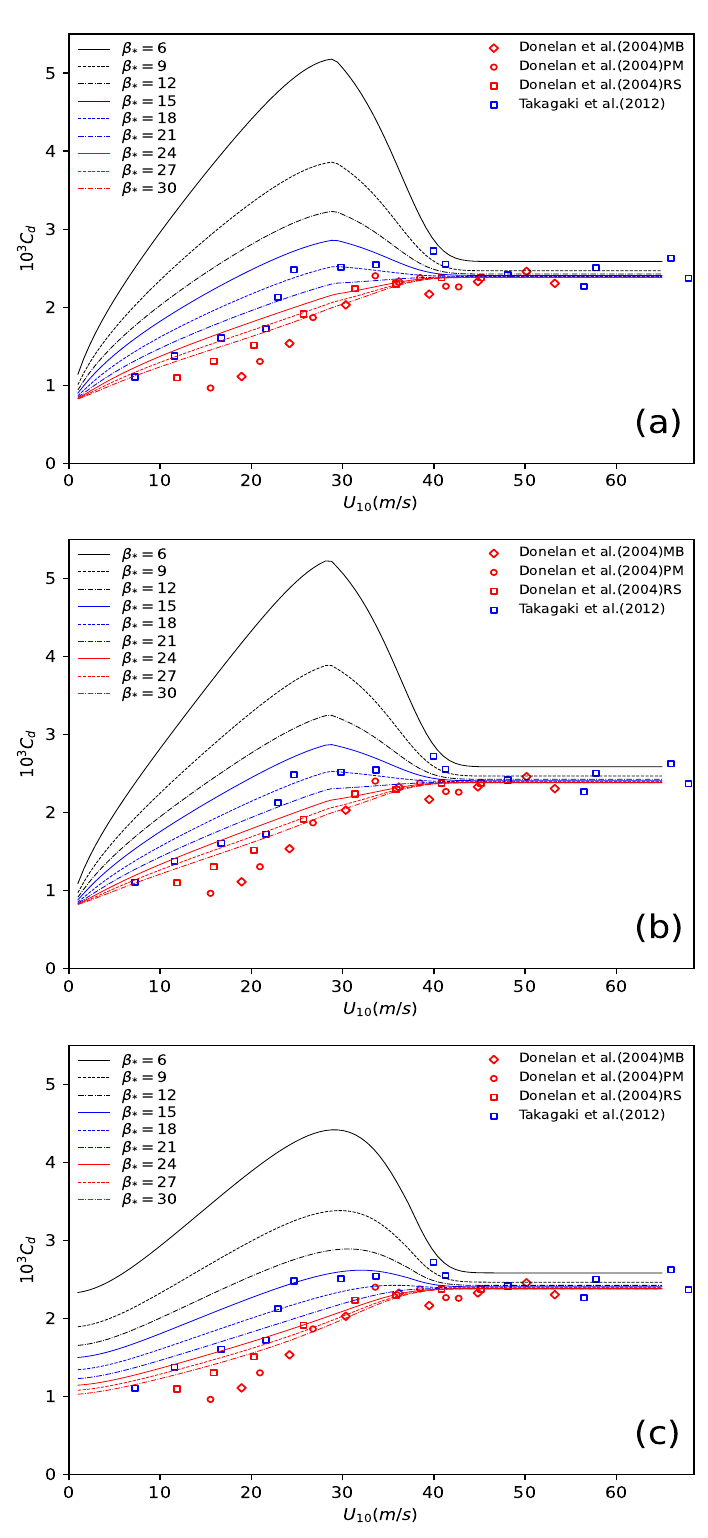
Figure 9. Comparison between C d predicted by the new parameterization under different wave ages using H s estimated from ( a ) Taylor and Yelland [51]; ( b ) Fairall et al. [81]; and ( c ) Wang et al. [82] and the laboratory